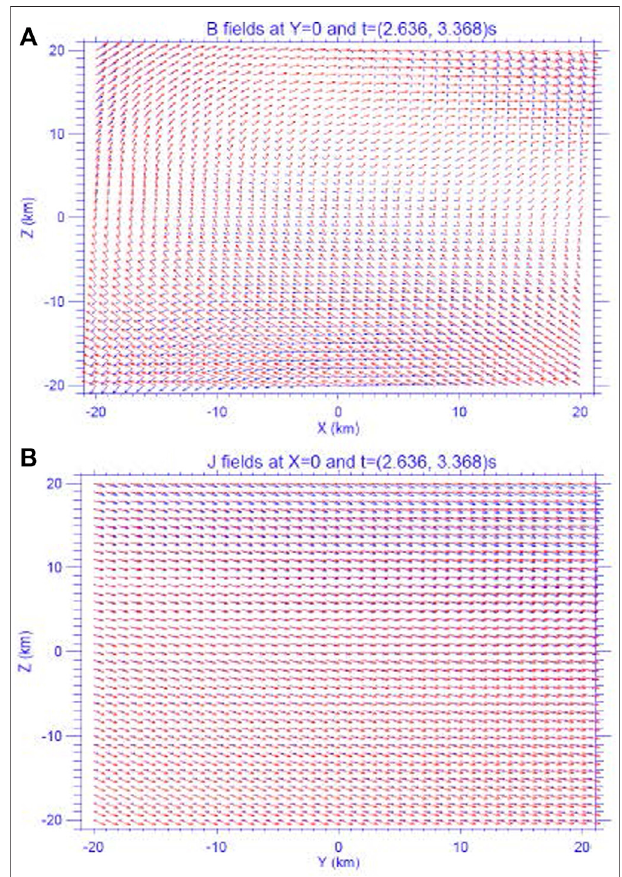
FIGURE 9 | (A) Modeled B fi elds projected into the X-Z plane of Y = 0 at two times of t (cid:1) 2 . 636 s (blue) and t (cid:1) 3 . 368 s (red) after 22:34 UT on 11 July 2017. (B) Modeled J fi elds projected into the Y-Z plane of X = 0 at the same two instances as in panel (A) . A signi fi cant intensi fi cation in J fi elds at t (cid:1) 3 . 368 s as indicated by a plot with dominant red